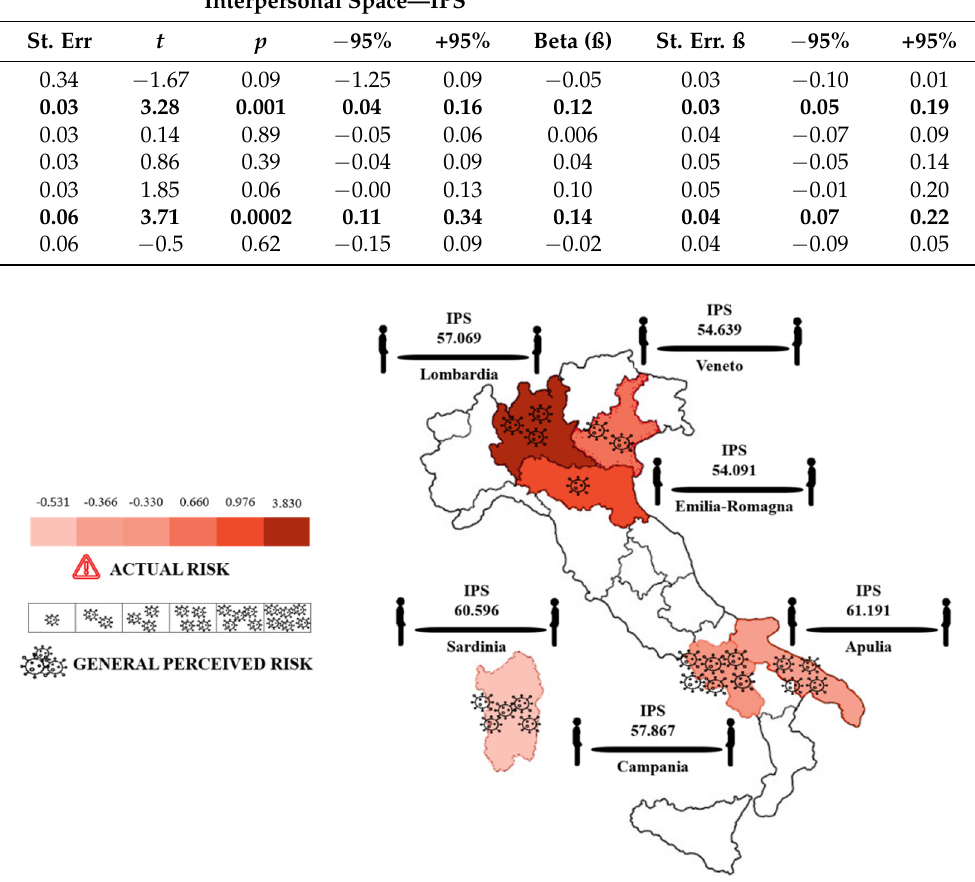
Figure 2. The figure shows the levels of actual risk (darker colors indicate higher levels of COVID-19 actual risk) and present general perceived risk (more virus icons indicate higher levels of perceived risk). Mean interpersonal distance (IPS) measured in the IVAS task for each region is also reported (straight black lines near each